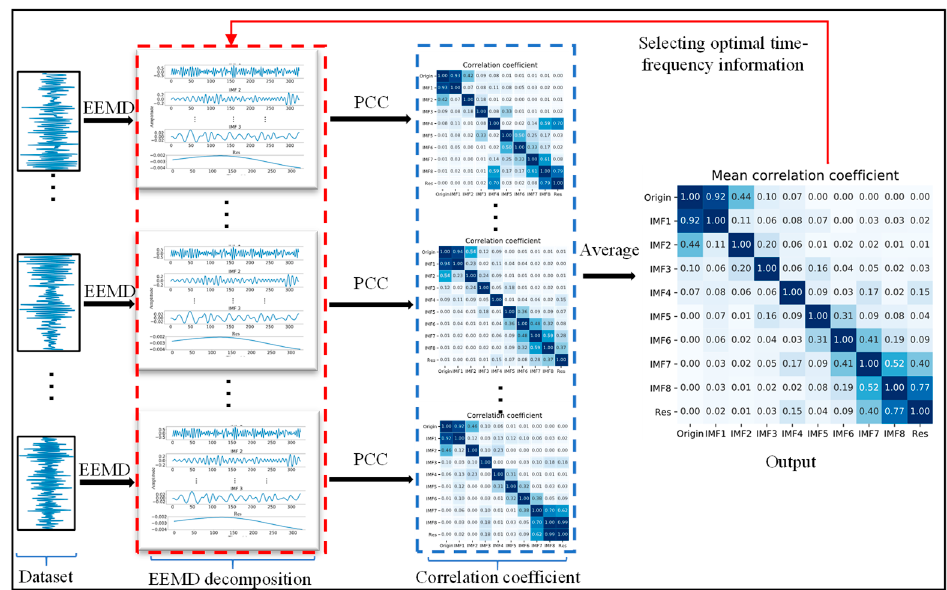
Figure 6. The procedure of optimal time-frequency selection.